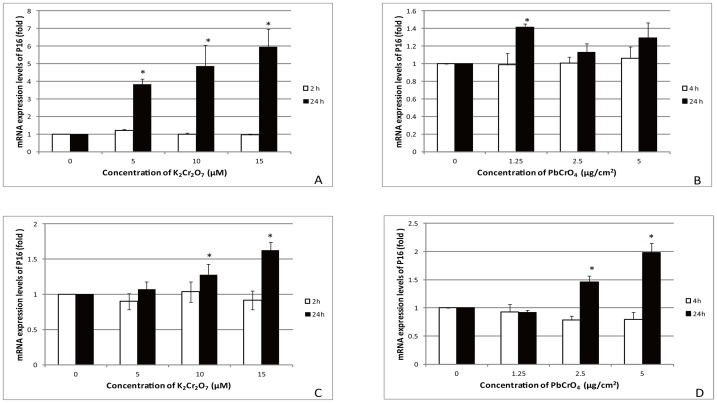
mRNA expression of p16 gene.A and C: mRNA expression levels (fold change) of p16 gene in human B lymphoblastoid cells (A) and in A549 cells (C) cells exposed to potassium dichromate at the concentrations of 0, 5 µM, 10 µM, and 15 µM for 2 hours and 24 hours. B and D: mRNA expression levels (fold change) of p16 gene in human B lymphoblastoid cells (B) and in A549 cells (D) cells exposed to lead chromate at the concentrations of 0, 1.25 µg/cm2, 2.5 µg/cm2, and 5.0 µg/cm2 for 4 hours and 24 hours. Asterisks above the bars indicate that the difference between exposure and control was significant (P<0.01).